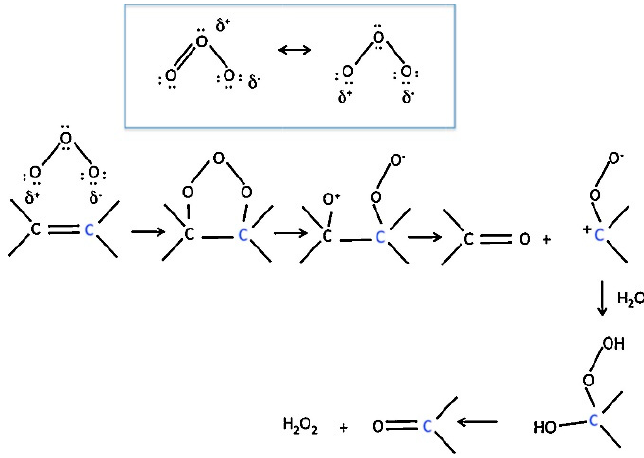
Figure 1. Schematic representation of direct O 3 reaction with unsaturated bond.